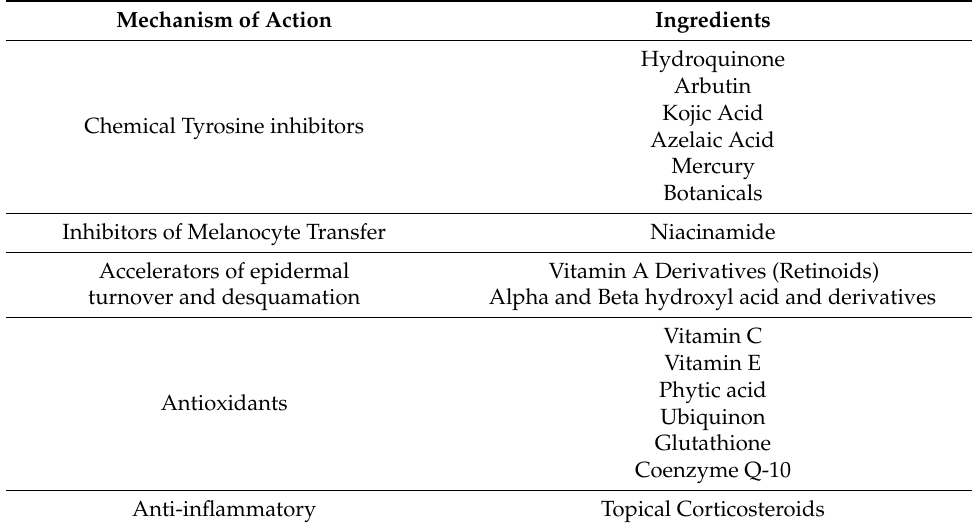
Table 1. Skin lighteners—Mechanism of action and